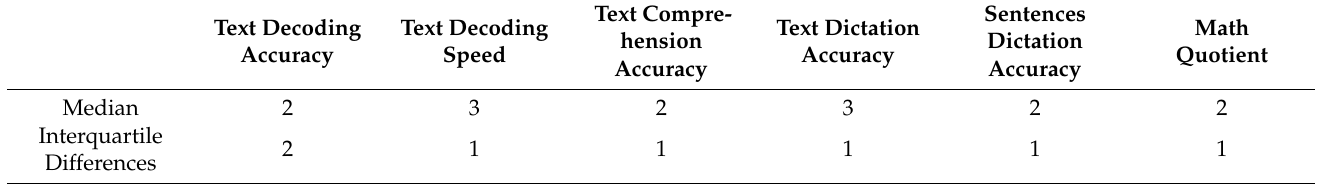
Table 1. Descriptive statistics of the score range (1, Normal, 2, Borderline, 3 Deficient) obtained at the academic tests.